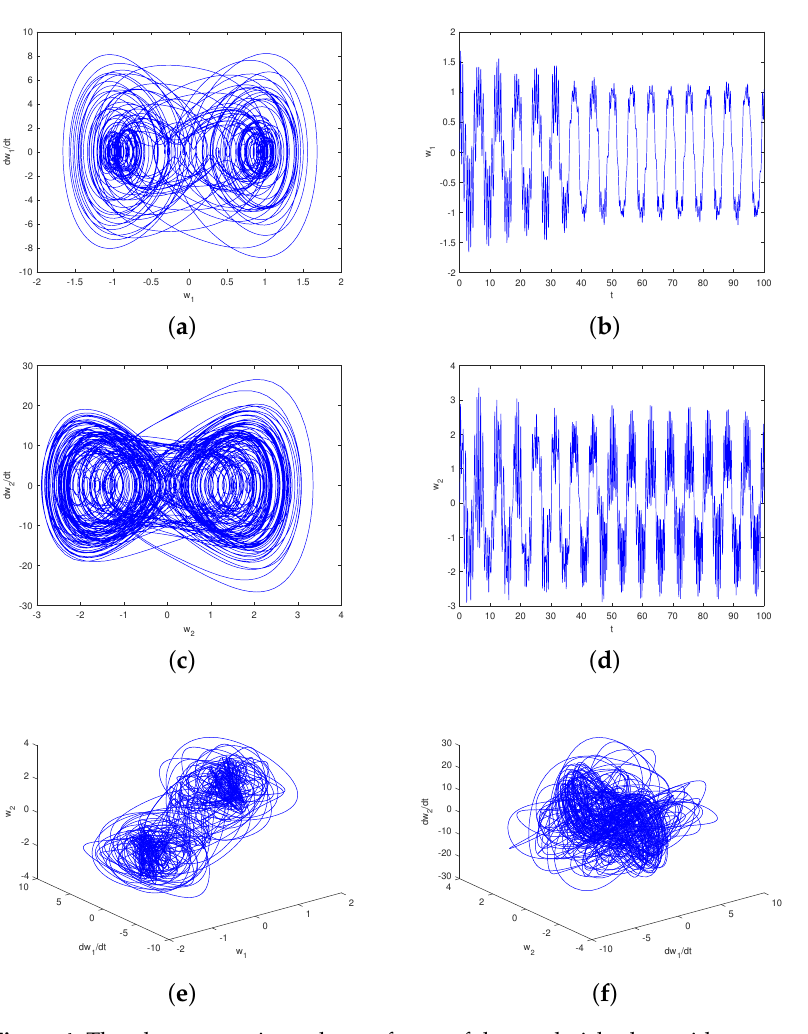
Figure 4. The phase portraits and waveforms of the sandwich plate with truss core when µ = 0.06 ) ; ( c ) the ) ; ( b ) the waveform on plane ( t , w and f = 100: ( a ) the phase portrait on plane ( w 1 , dw 1 1 dt ) ; ( d ) the waveform on plane ( t , w ) ; ( e ) the phase portraits in phase portrait on plane ( w 2 , dw 2 2 dt the three-dimensional space ( w 1 , dw 1 , w 2 ) ; ( f ) the phase portraits in the three-dimensional space dt ( dw 1 ) . , w 2 , dw 2 dt dt